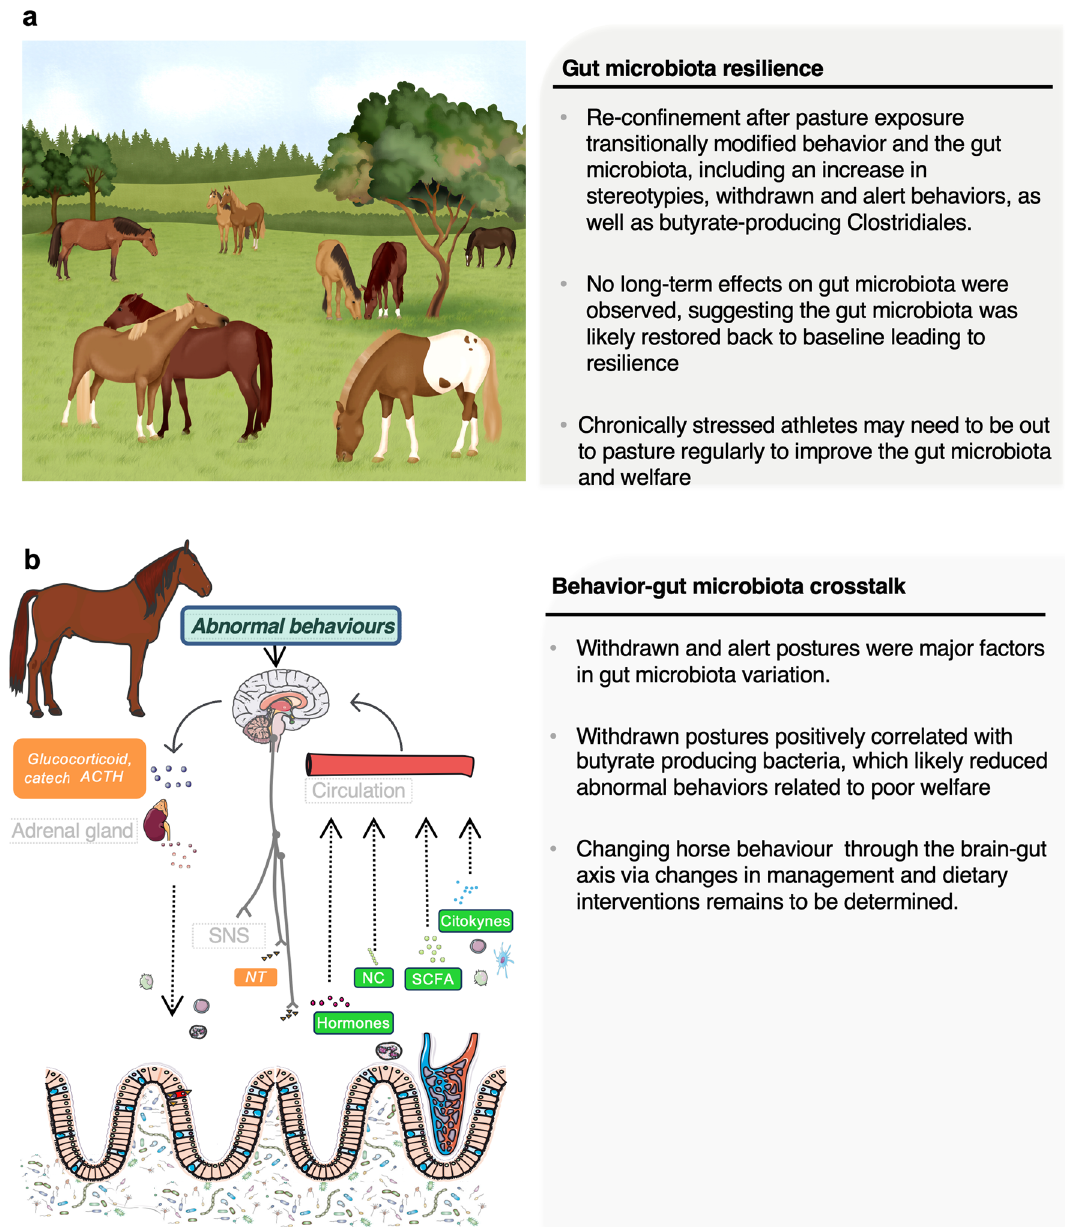
Figure 6. Main results and future hypothesis. ( a ) Key results obtained after the release of horse athletes in the pasture for a short- term period; ( b ) behaviors pointing to poor welfare as a modulator of gut microbial ecology. Abnormal behaviors might cause stress, thereby inducing the secretion of adrenocorticotropic hormone (ACTH), which in turn acts on the inner adrenal cortex to initiate the synthesis and release of glucocorticoid and catecholamines hormones, or by inducing the release of sympathetic neurotransmitters (epinephrine and norepinephrine). Additionally, the gastrointestinal tract responds to stress by releasing neuroactive molecules such as Gamma-amino butyric acid (GABA), neuropeptide Y and dopamine that have been purported to be involved in the gastrointestinal disturbances, anxiety, depression, reduced food intake and less stress coping (reviewed by Clark and Mach 74 ). These stress molecules might influence bacterial gene expression or signaling between bacteria, and this might change the microbial composition and function of the microbiota. The putative mechanisms by which the gut microbiota interacts with the brain and influences behavior in athletes include bacterial subproducts (SCFA, H 2 S, indolic compounds, secondary bile acids), the synthesis or stimulation of endogenous neuroactive substances like (GABA, dopamine and serotonin) that gain access to the brain via the bloodstream, via cytokine release from mucosal immune cells, or via afferent neural pathways, including the vagus nerve. However, the extent to which the gut microbiota-gut-brain axis, and modulation of the gut microbiota through this axis influences behavior in athletes remains to be determined. ACTH adrenocorticotropic hormone, NT neurotransmitters, NC neuroactive compounds, SCFA short chain fatty acids. Written permission for publication of the drawing in the ( a ) panel has been given. In the ( b ) panel, the picture of the horse was downloaded from https ://smart .servi er.com/wp-conte nt/uploa ds/2016/10/Anima ls.ppt. The image of the brain was download from https ://smart .servi er.com/categ ory/anato my-and-the-human -body/nervo us-syste m/brain /. The image of the gut intestinal cells was downloaded from https ://smart .servi er.com/smart _image /intes tinal -villi /. The kidney image was download from https ://smart .servi er.com/smart _image /kidne y-2/. The immune cell representation and the blood capillary were obtained from https ://smart .servi er.com/ categ ory/anato my-and-the-human -body/cardi ovasc ular-syste m/blood / . In all cases, no changes were made. Servier Medical Art by Servier is licensed under a Creative Commons Attribution 3.0 Unported